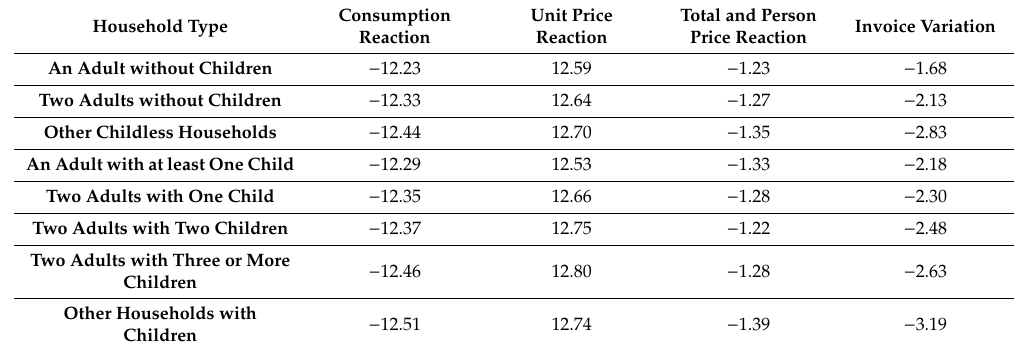
Table 9. Variations by Household